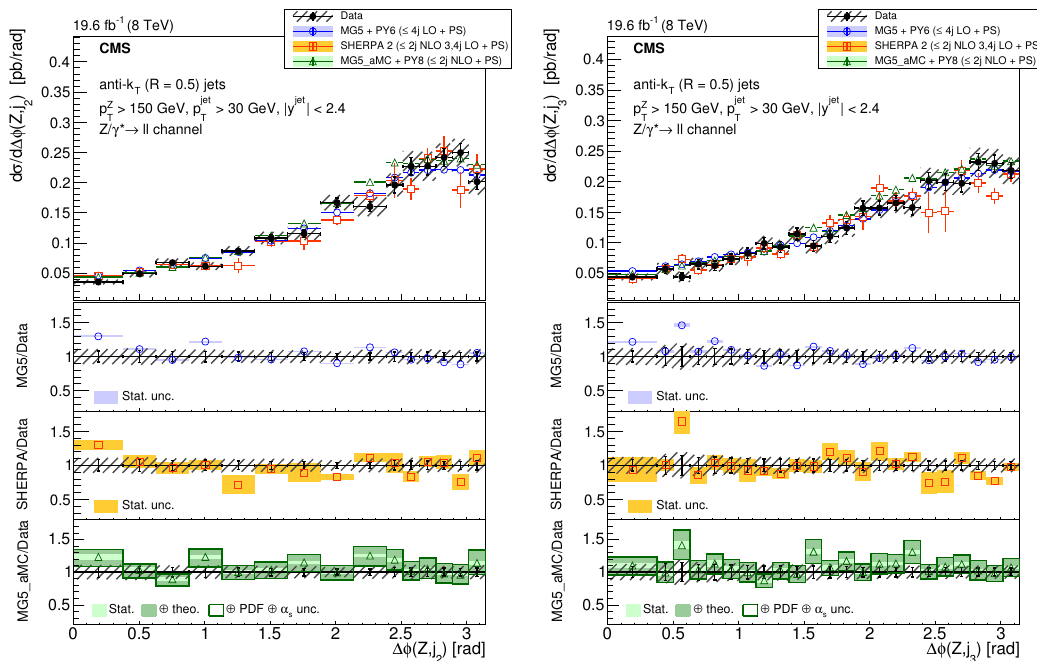
Figure 21 . The di(cid:11)erential cross section for Z ( ! ‘‘ ) + jets production for N jets (cid:21) 3 and p T (Z) > 150 GeV as a function of the azimuthal angle (left) between the Z boson and the sec- ond leading jet and (right) between Z boson and third-leading jet. The lower panels show the ratios of the theoretical predictions to the measurements. Error bars around the experimental points show the statistical uncertainty, while the cross-hatched bands indicate the statistical and systematic un- certainties added in quadrature. The boxes around the mg5 a mc + pythia 8 to measurement ratio represent the uncertainty on the prediction, including statistical, theoretical (from scale variations), and PDF uncertainties. The dark green area represents the statistical and theoretical uncertainties only, while the light green area represents the statistical uncertainty